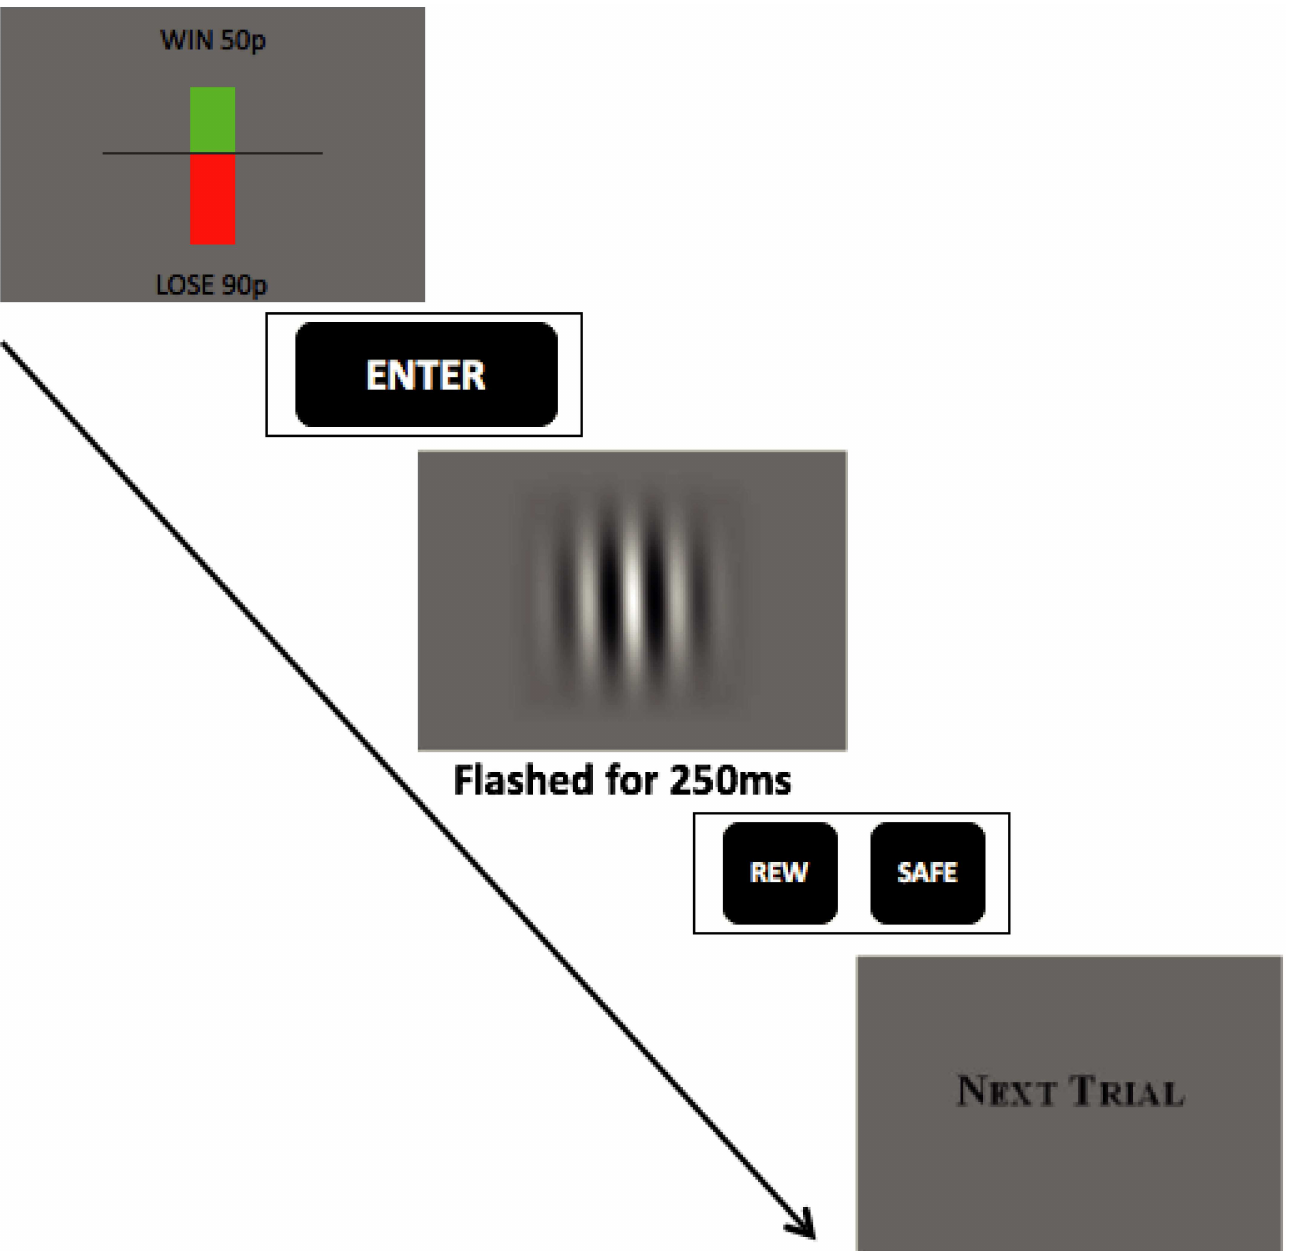
Fig 1. The judgement bias task. Each trial started with presentation of the trial-specific offered win (indicatedby the green bar) and threatenedloss (red bar). Subjects studied this informationand then pressed the ‘Enter’ key. A Gabor patch stimulus was then flashed on the screen for 250ms. The subject had to decide which way the patch was leaningand press either the REW or SAFE key as appropriate. The next trial then followed. See text for